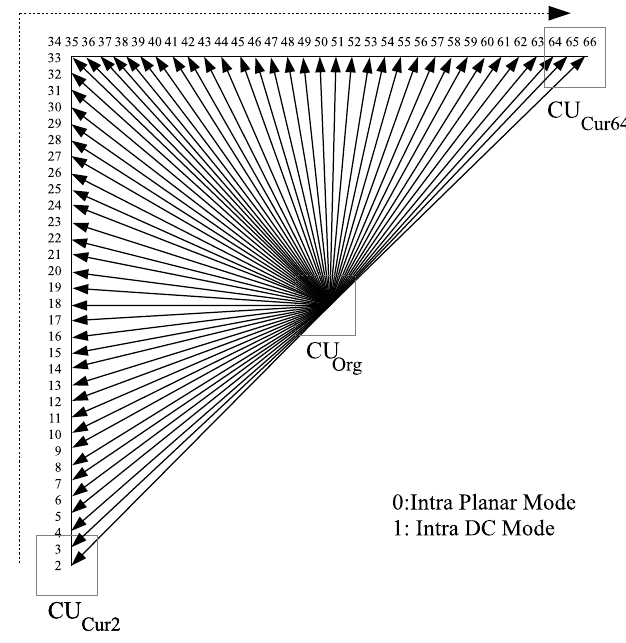
Figure 4. Extended (red) prediction modes in JEM [17].